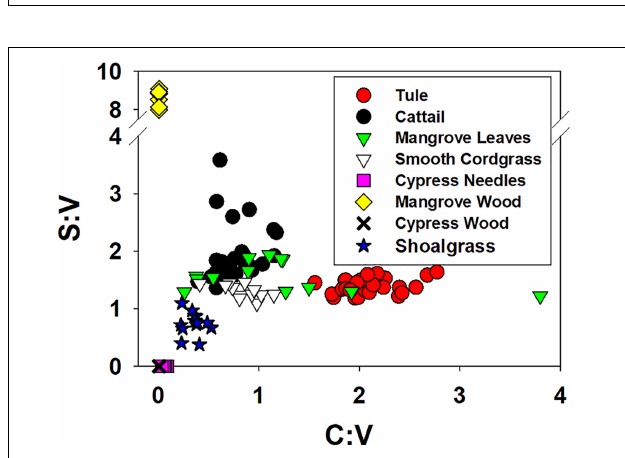
FIGURE 6 | S:V ratios (sum of the syringyl phenols divided by the sum of the vanillyl phenols) versus C:V ratios for this study along with data from the litterbag studies of Opsahl and Benner (1995).